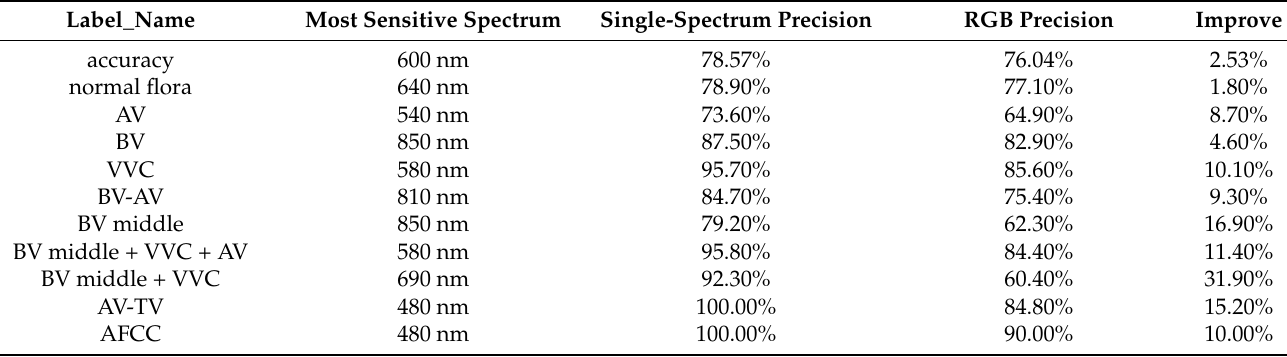
Figure 5. ( a ) is the RGB image of a typical visual field of BV middle + VVC in visible light. ( b – g ) are the images collected under the 440 nm, 500 nm, 620 nm, 750 nm, and 850 nm spectrum, respectively. ( e ) is the most sensitive band photograph collected under the 690 nm spectrum. It can be seen that the 690 nm single-spectrum image suppresses some cells and microorganisms in the image while enhancing the lactobacilli compared to the RGB image. Table 8. Multi-classification result of single-spectrum image and RGB image, and AFCC is abnormal flora combined